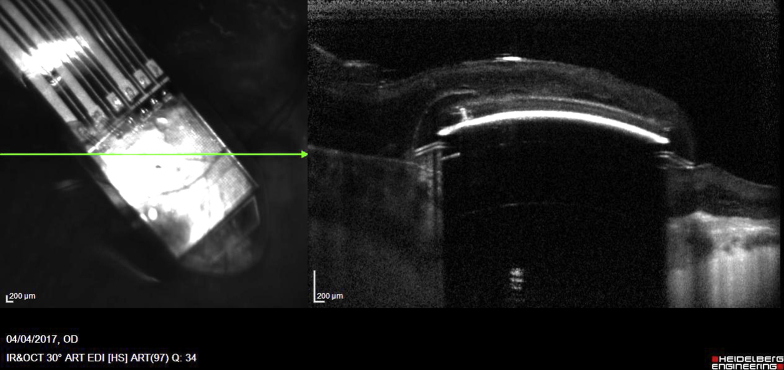
Optical coherence tomography scan (Heidelberg Engineering, Inc., Heidelberg, Germany) of P4 after reimplantation of a new Alpha AMS device (Retina Implant AG, Reutlingen, Germany).